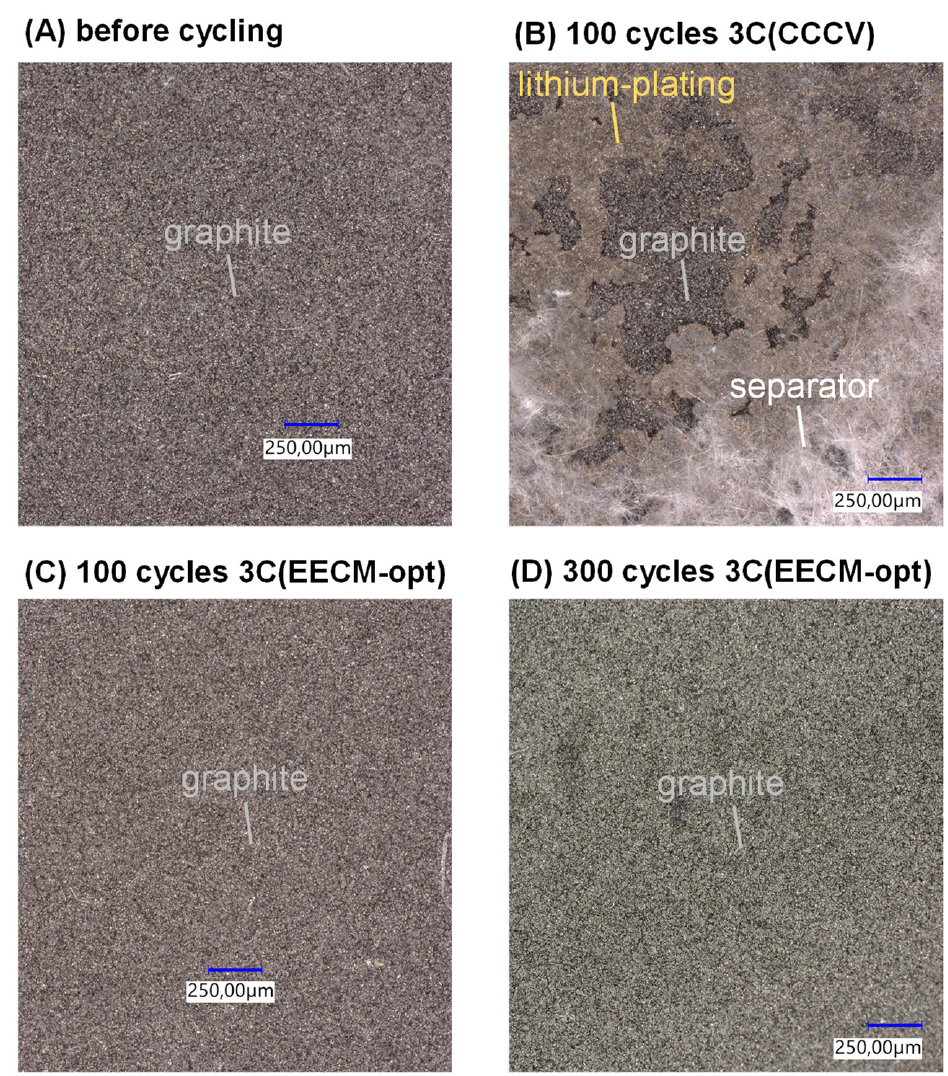
Figure 6. Optical post-mortem inspection (100 × zoom) of the negative electrodes under argon atmosphere. ( A ) There is no visible lithium-plating before cycling. ( B ) The 3C(CCCV) strategy leads to lithium-plating during the first 100 cycles, which is partly attached to separator fibers. ( C ) The optimized strategy 3C(EECM-opt) does not lead to visible lithium-plating after 100 cycles. ( D ) The optimized strategy 3C(EECM-opt) does not lead to visible lithium-plating after 300